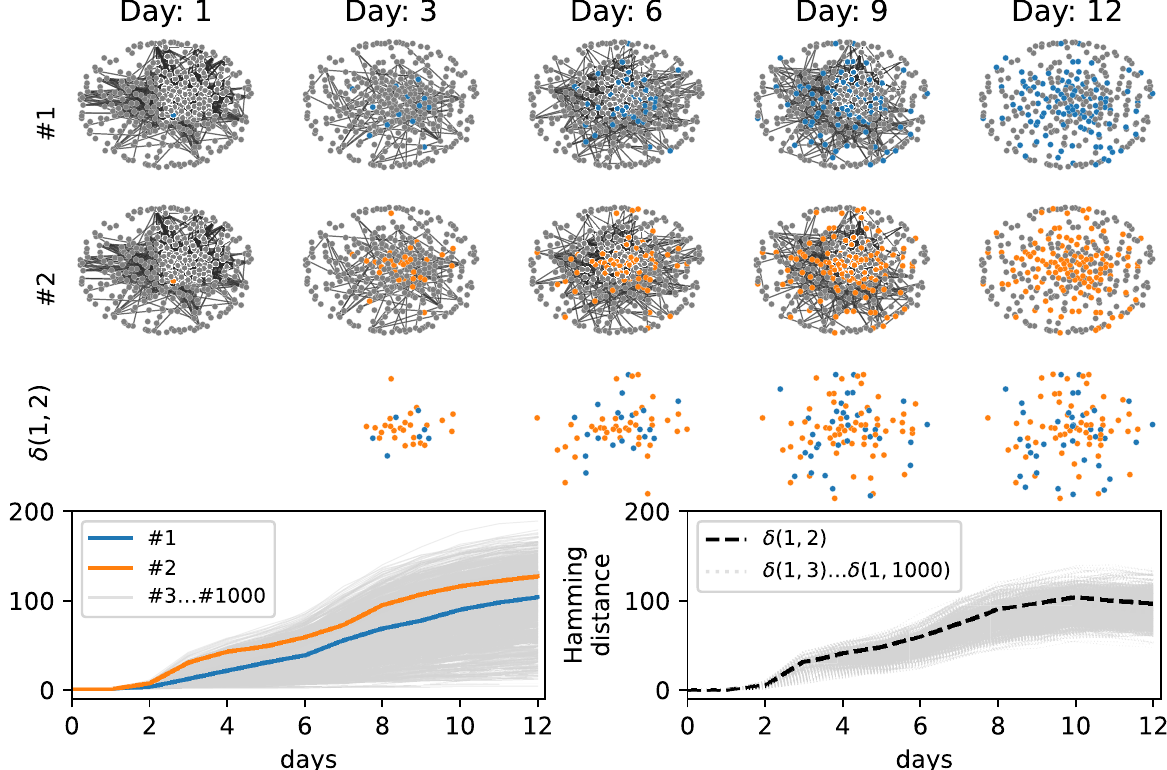
Figure 1. Simulated epidemic cascades in a hospital contact network. One thousand epidemic cascades simulated (with the same epidemic parameters) on a real contact graph measured in a hospital 22 (detailed information about epidemic models and contact networks are listed in the "Results" section). The epidemics started from the same individual. Two samples (blue, and orange) of epidemic cascades are shown in the first and second rows of the figure. The third row represents the distance between them, where in this case the blue dots are the infected individuals present in the cascade 1 but not in cascade 2 and the orange ones are those present in cascade 2 but not in cascade 1. In the third row, the total number of blue and orange dots gives the Hamming distance between the two daily configurations. Left-bottom plot. Cumulative number of infected individuals for 1000 epidemic cascades started from the same individual. Right-bottom plot. Hamming distance ( δ( 1, i ) ) between the cascade 1 and all the others i ∈ [ 2, 3 . . . 1000 ]